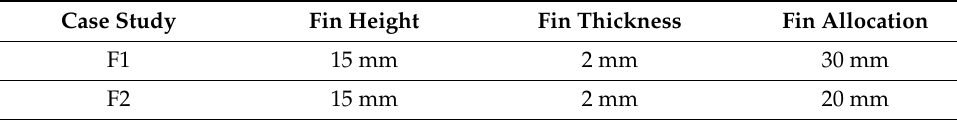
Table 5. Fin arrangement